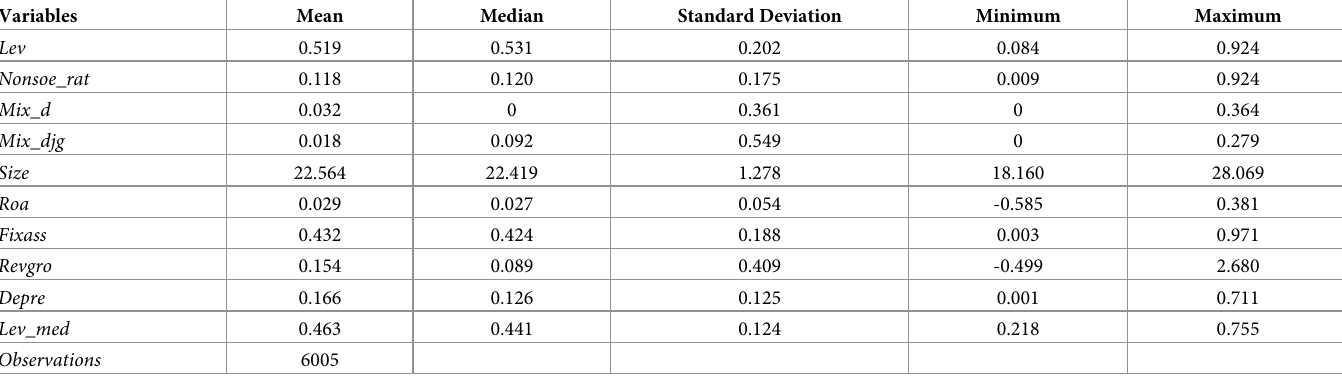
Table 2. Descriptive